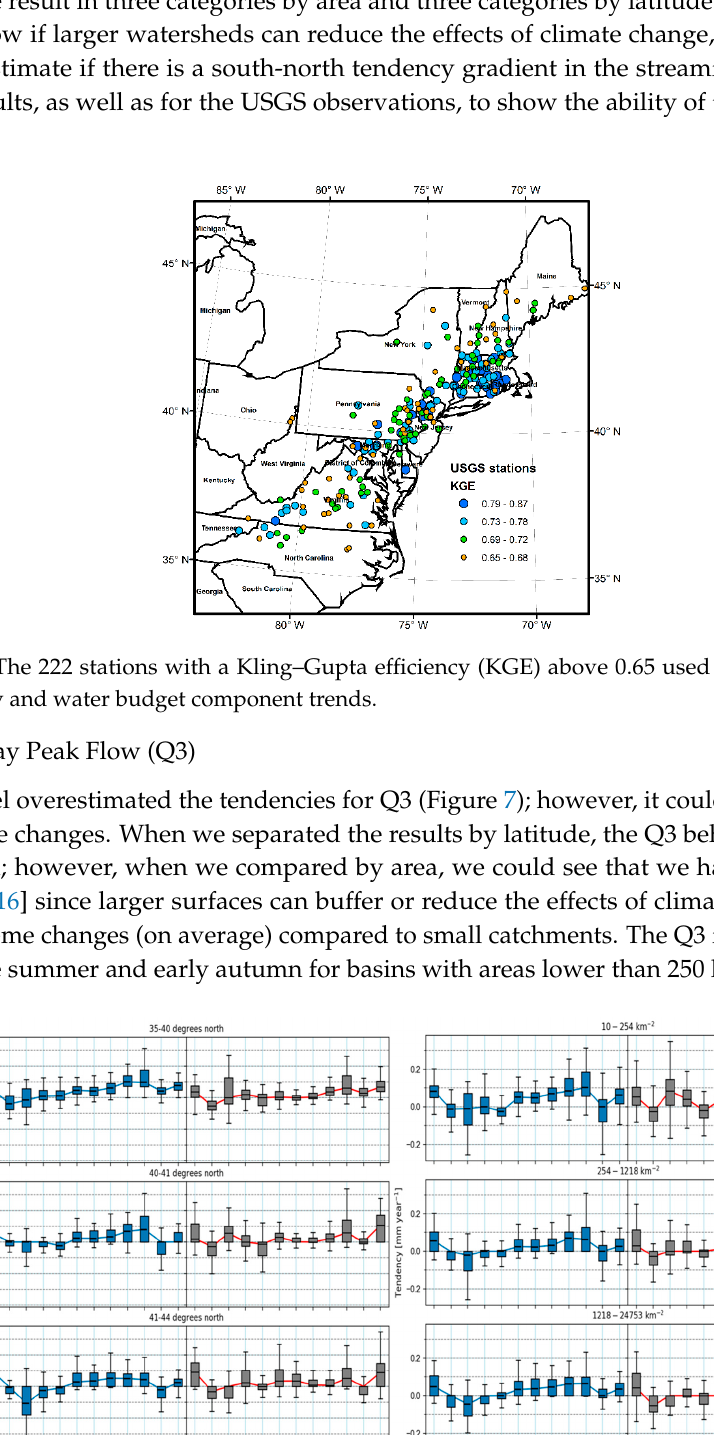
Figure 5. Nash Sutcliffe efficiency, root mean square error (RMSE) - observations standard deviation ratio, and percentage bias monthly streamflow for the period of 1980–2015, according to Table 4 from Reference [40].